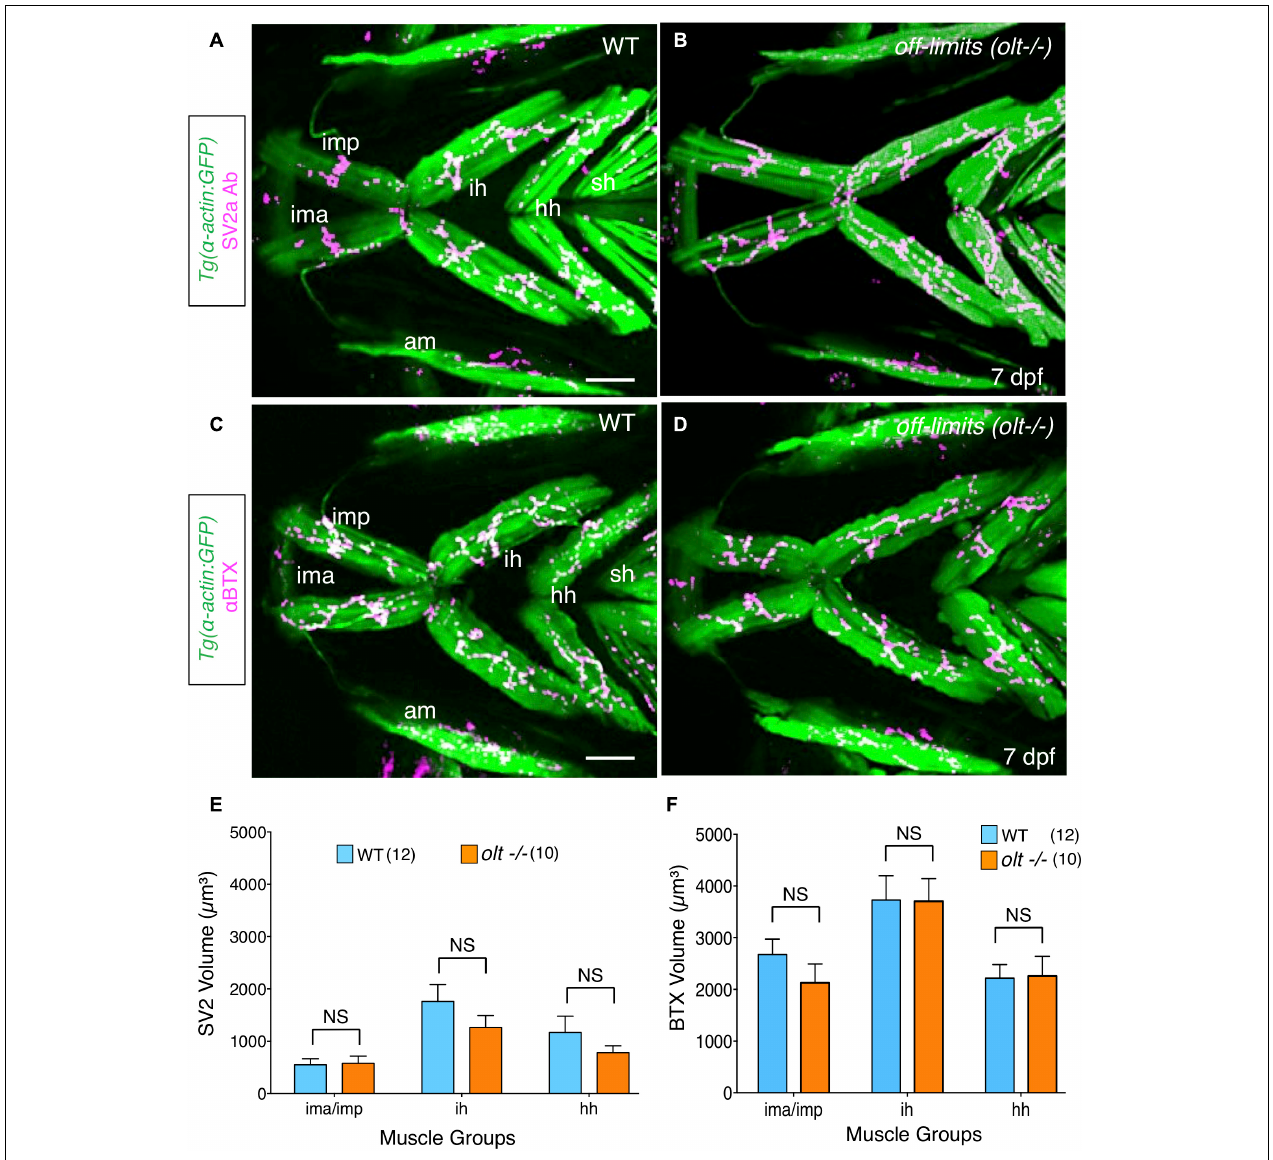
FIGURE 6 | Neuromuscular junctions on jaw muscles in olt mutants are unaffected. (A–D) Ventral view with anterior to the left of the jaw musculature in 7 dpf Tg(isl1:GFP);Tg( α -actin:GFP) larvae. (A,B) SV2a antibody staining (magenta) of presynaptic structures on the jaw muscles (green). (C,D) Postsynaptic Acetylcholine receptor (AChR) clusters were labeled with alpha-bungarotoxin ( α BTX) (magenta) on the jaw muscles (green) in live larvae. Volumes of the presynaptic structures and postsynaptic clusters were calculated from 3D renderings by using the muscle as a mask. There was no significant difference in the volumes of SV2a-stained structures (E) or α BTX-labeled structures (F) on any muscle groups between wildtype siblings and olt mutants. Data pooled from 3 experiments (number of larvae in parenthesis). The two-tailed student t -test was performed to test for significance. NS, not significant. ima/imp, intermandibularis anterior/intermandibularis posterior; ih, interhyal; hh, hyohal; am, adductor mandibularis; sh, sternohyoideus. Scale bar (A,C) , 100 µ